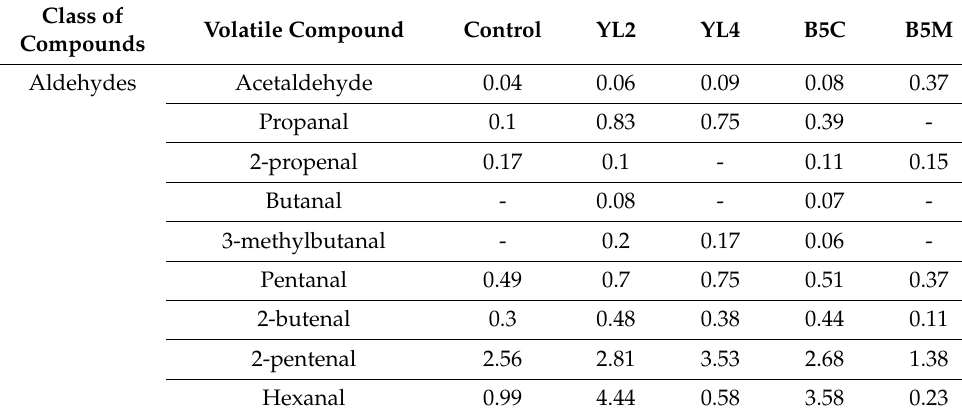
Table 3. Volatile molecule profiles (expressed as relative abundance, %) of fish waste solution incubated with Y. lipolytica YL2, YL4, B. subtilis B5C or B. amyloliquefaciens B5M for 72 h. Data are the mean of three different samples. The variability coefficient ranged between 5% and 7%. Results are the average of two replicates ( n =